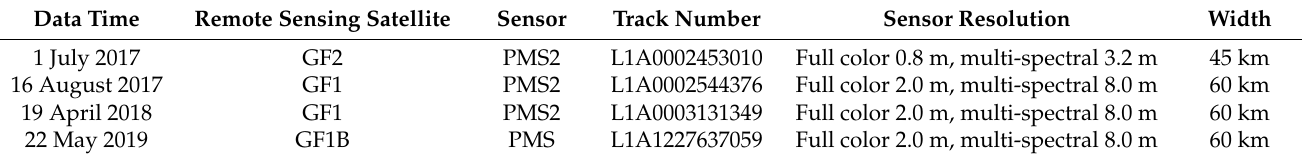
Table 1 for details of the data. The scale of the DEM data in the study area is 1:250,000. Table 1. Data selection for remote sensing monitoring and evaluation of the lake landscape in the Jiuzhaigou scenic area.